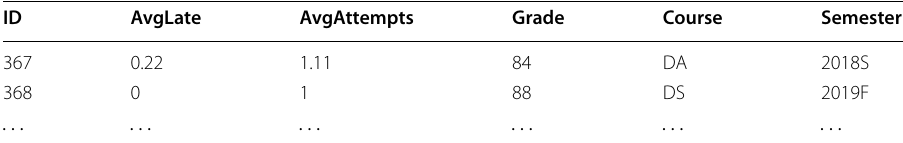
Table 1 Example of data from ITM-Academics